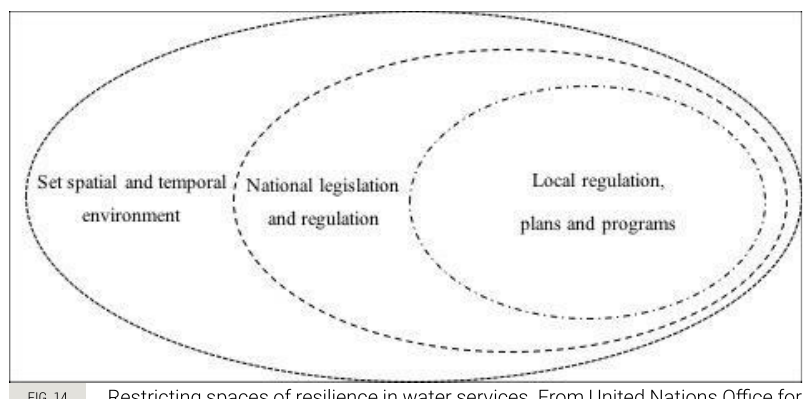
Restricting spaces of resilience in water services. From United Nations Office for Disaster Risk Reduction, UNISDR. “Terminology.” Accessed February 28, 2019